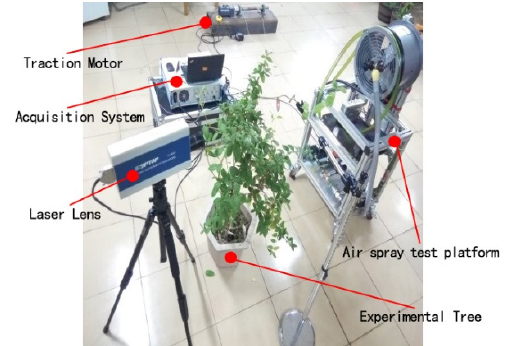
Figure 6. Field diagram of the spray test with different operating parameters.